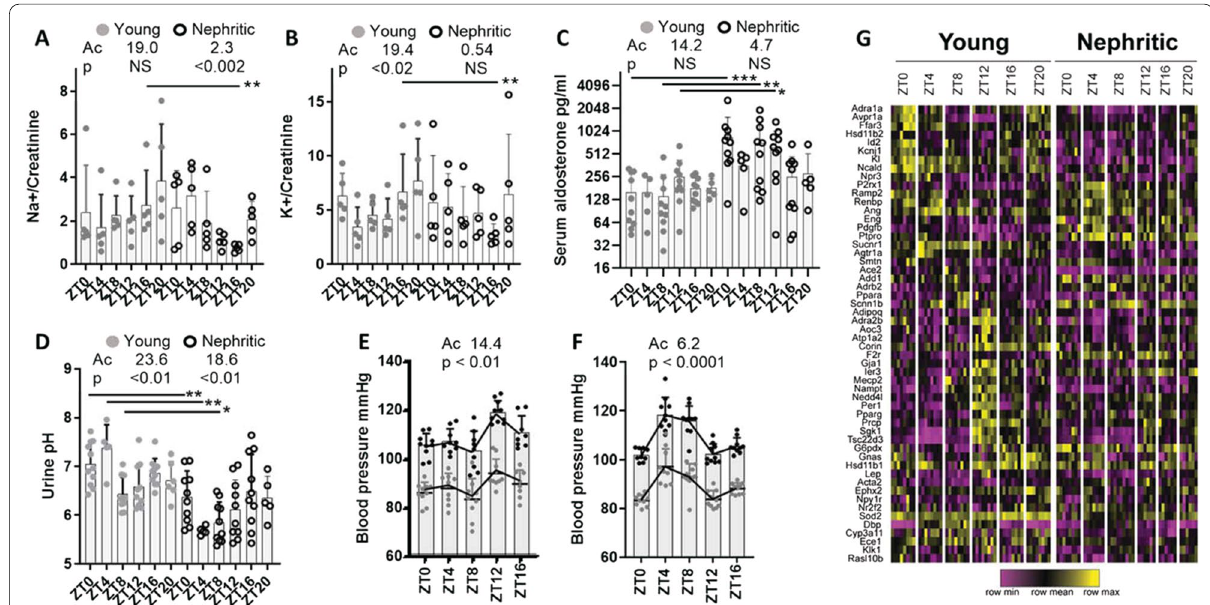
Fig. 4 Dysregulated circadian regulation of renal salt excretion and blood pressure in nephritic mice A Urine Na Creatinine ratio Urine pH; C Serum aldosterone; D Urine pH; E, F : systolic (black) and diastolic (grey) blood pressure in young ( E ) and nephritic ( F ) mice shows reverse dipping pattern in nephritic mice;—each symbol represents one mouse. G Heatmap of genes that contribute to regulation of blood pressure. Samples are the same as those shown in Additional file 1: Figure S2. Rhythmicity was evaluated by Cosinor analysis (Ac